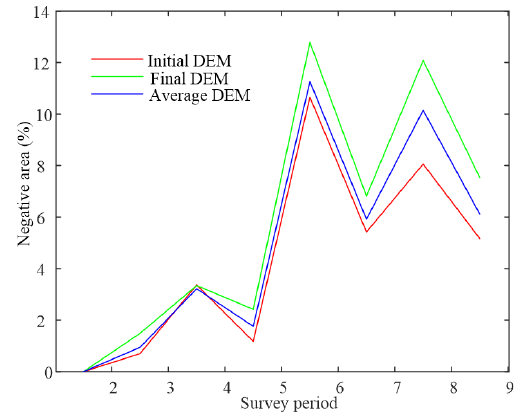
Figure 6 . comparison the use of initial, final, and average